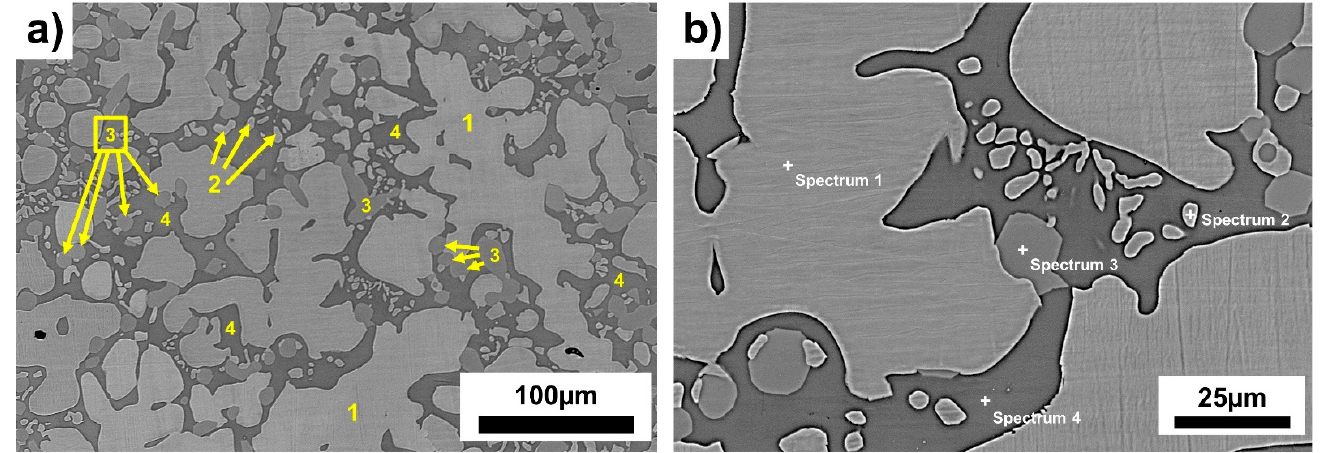
Figure 1. Backscattered electron micrograph of the induction-melted 1.2Ti–0.8Fe alloy ( a ) low mag- nification: regions 1, 2, 3 and 4 match the EDX spectrums, and ( b ) higher magnifications: EDX point spectrums. Table 1. EDX analysis of the induction-melted 1.2Ti–0.8Fe alloy (uncertainty is ±1 for all values).